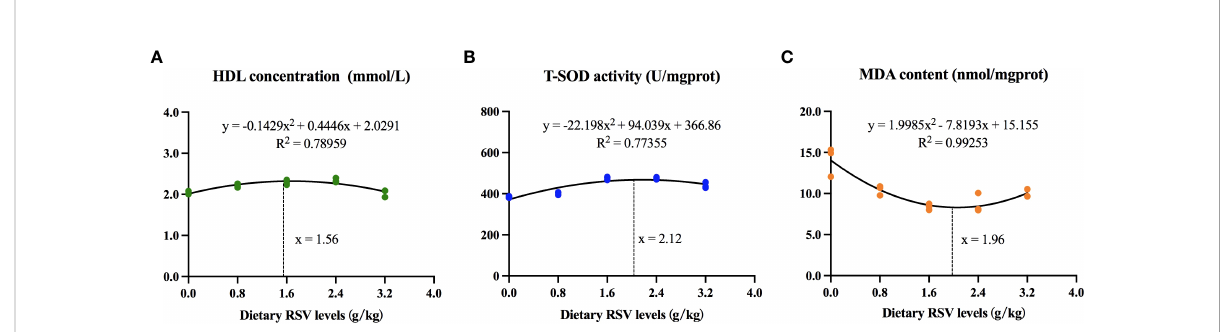
FIGURE 6 Dietary RSV requirements for common carp based on (A) high-density lipoprotein (HDL) concentration, (B) total superoxide dismutase (T-SOD) activity and (C) malondialdehyde (MDA)